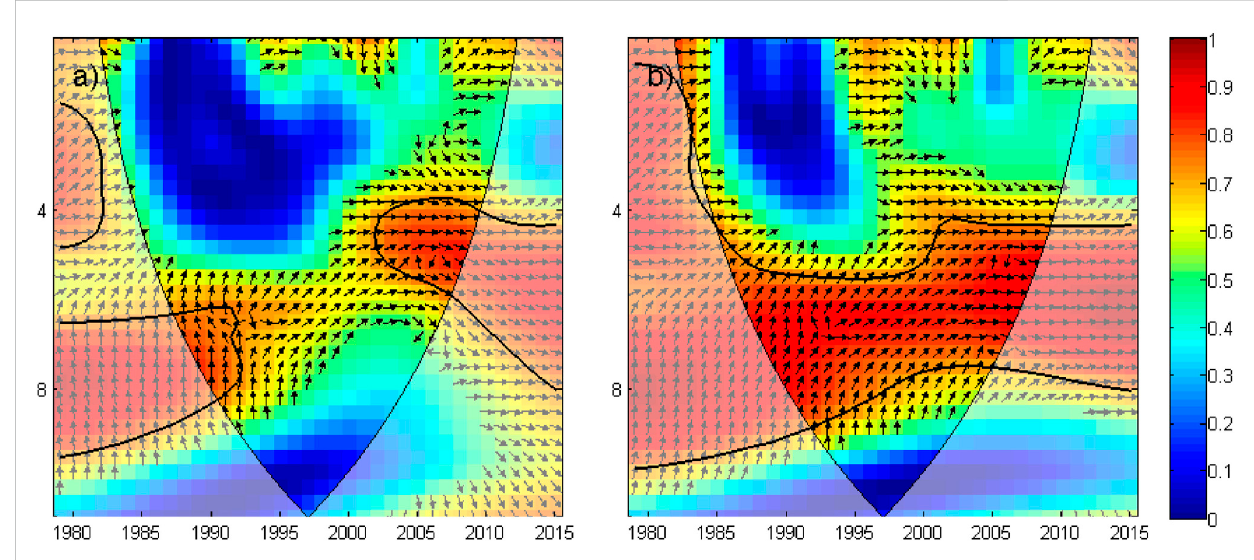
FIGURE 6 Wavelet coherent spectra of annual mean precipitation indices and SCSH over the MLYR from 1979 to 2015: (A) PRCPTOT and SCSHI, (B) R25 mm and SCSHI.